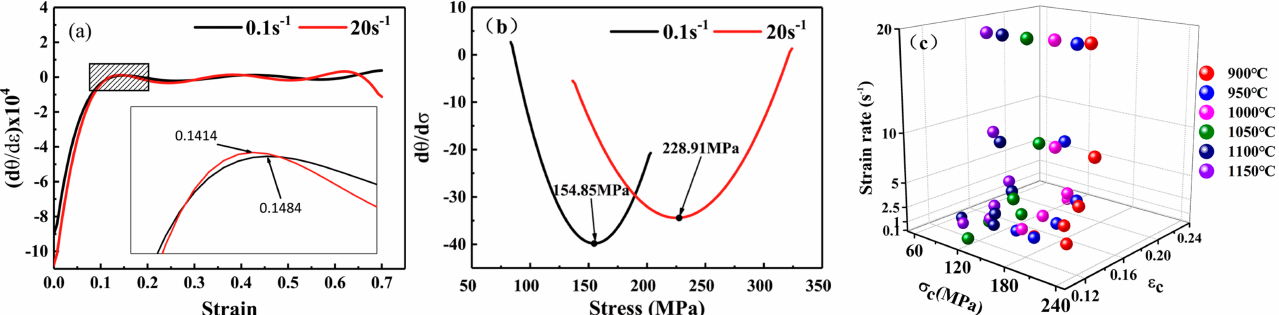
Figure 7. Variation of ( a ) d( θ )/d( σ )—strain, ( b ) d( θ )/d( σ )—stress at 900 ◦ C, and ( c ) the plot of σ c and ε c under different